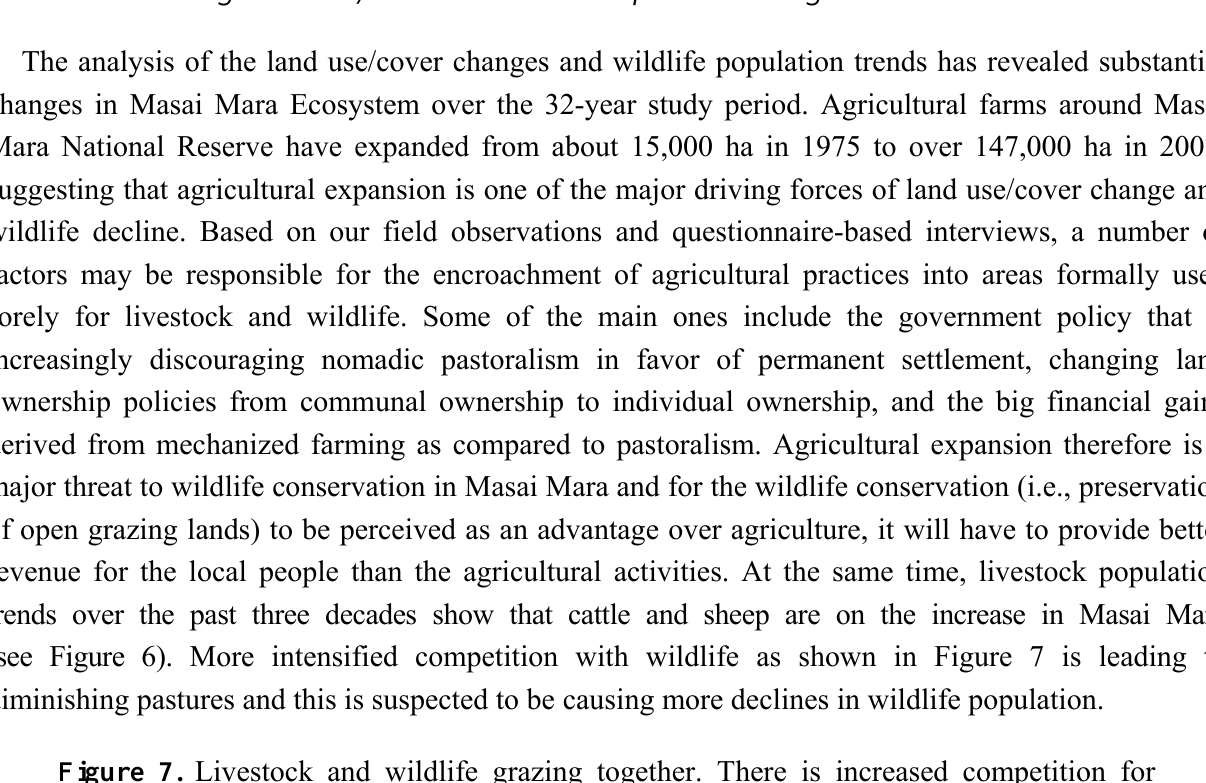
Figure 7. Livestock and wildlife grazing together. There is increased competition for pastures due to increasing livestock production in Masai